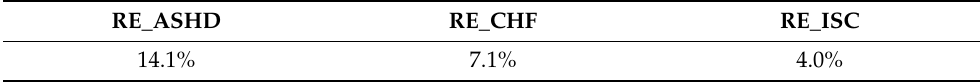
Table 4. The recurrence proportion of study complications in type 2 diabetes mellitus within 15 years. RE_ASHD RE_CHF RE_ISC 14.1% 7.1% 4.0%